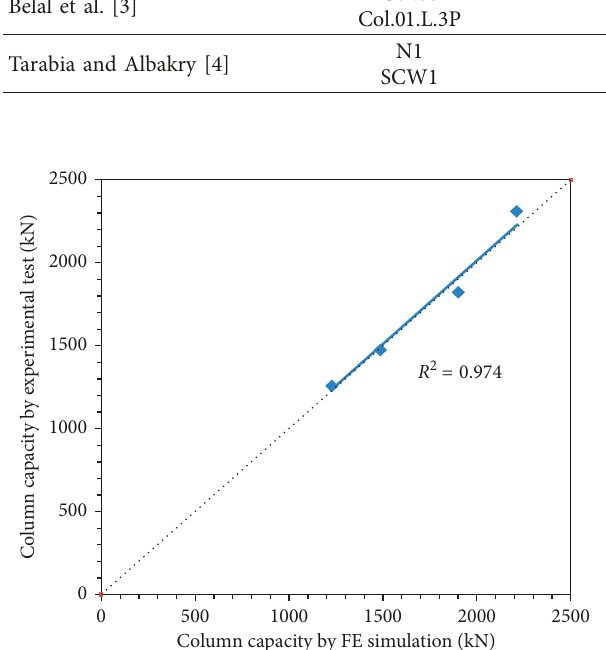
Figure 2: A comparison of the experimental and FE analysis values for axial load capacity.